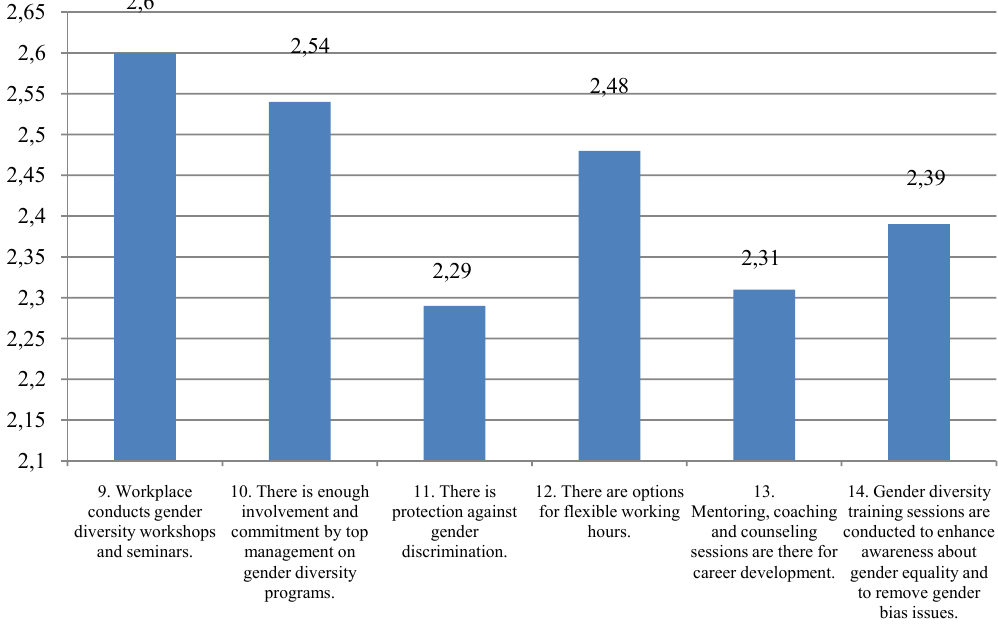
Fig. 2. Gender diversity management programs and practices